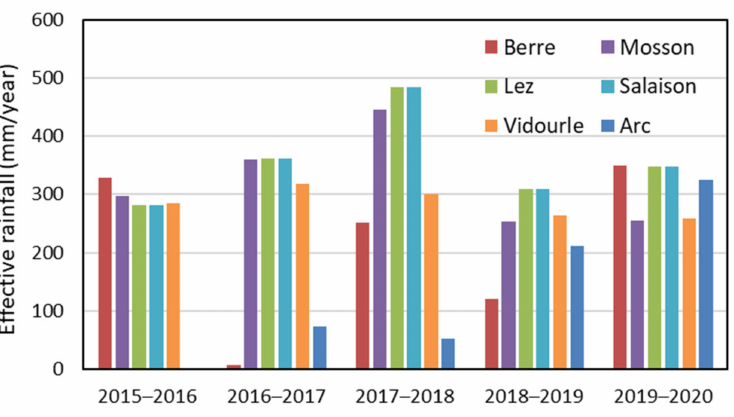
Figure 3. Effective rainfall (mm/year) calculated for the six